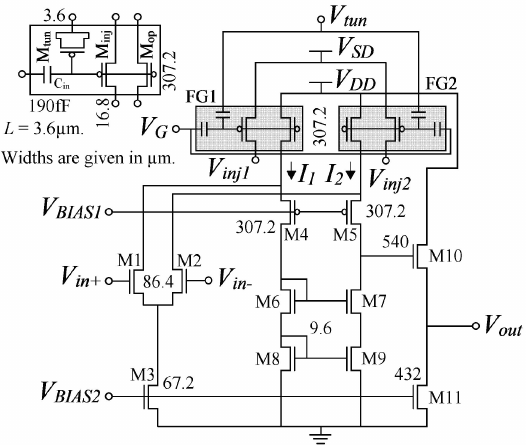
Figure 3. The POOA circuit design. FG1 and FG2 are indirect programming floating-gate structures, M1 and M2 are the input differential pair transistors, M4–M9 are the folded-cascode transistors, and M10–M11 are the output buffer